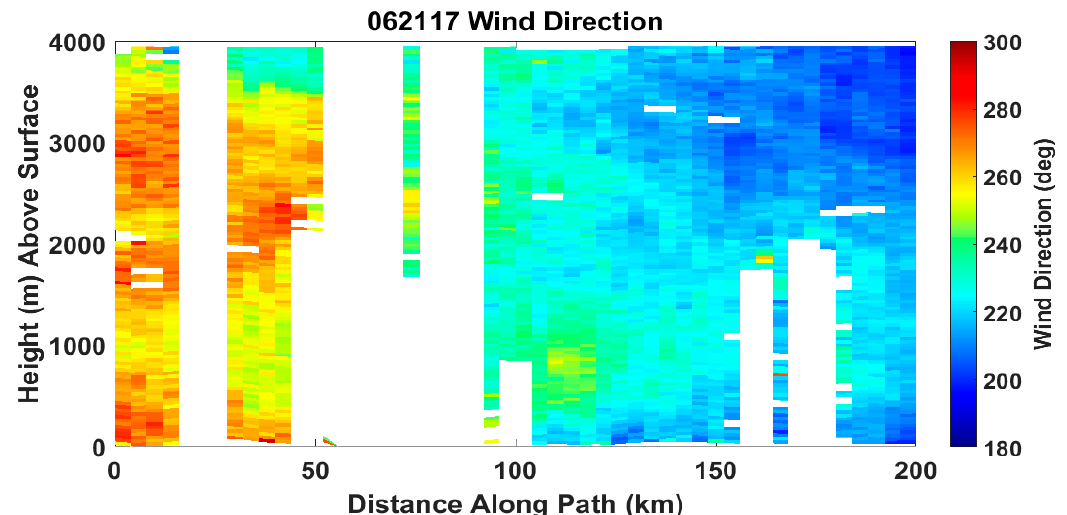
Figure 21. Curtain of DAWN wind speed profiles south of TS Cindy Center between 213855Z and 215839Z on 21 June 2017.